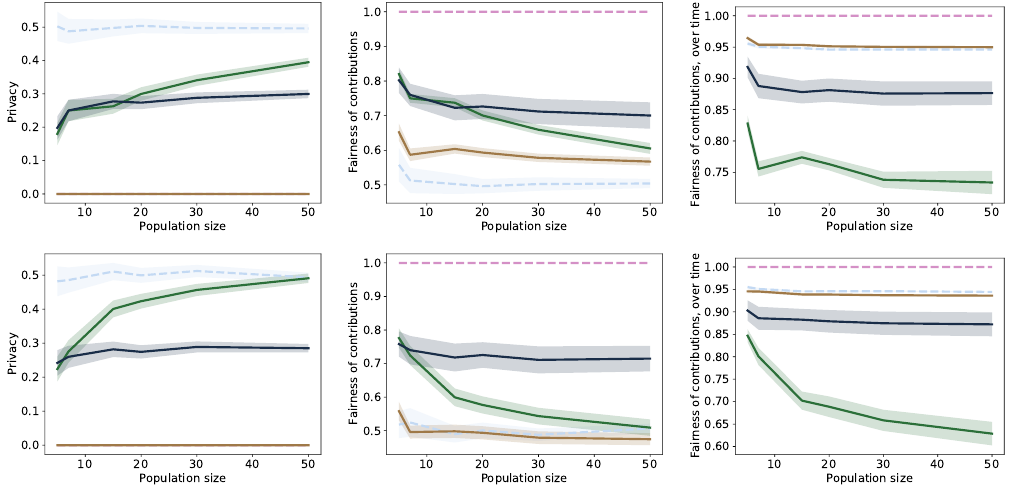
( c ) Social welfare of the population;